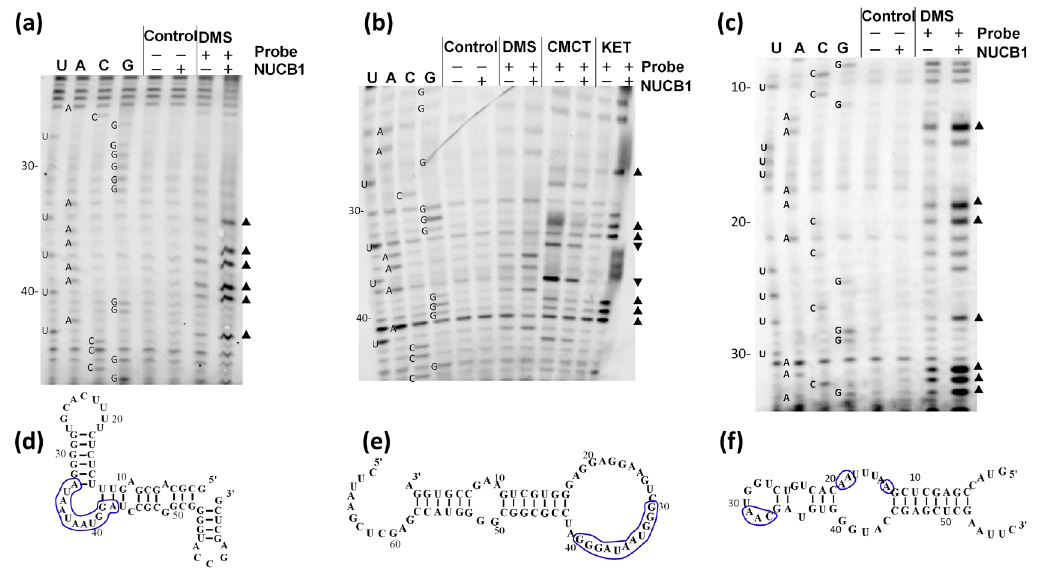
Figure 2. Chemical probing of the RNAs alone and in the presence of NUCB1 . ( a – c ) Representative gels showing structure probing of E - box RNA ( a ), SRP19 mRNA ( b ), and miR - 200a 3p RNA ( c ) using DMS, CMCT, and kethoxal (KET) in the presence and absence of NUCB1. Unmodified RNAs alone or in the complex with NUCB1 were used as controls. U, A, C, and G are sequencing lanes generated by reverse transcription in the presence of ddATP, ddTTP, ddGTP, and ddCTP, respectively. Nucleotides are numbered according to their position in an RNA transcript. The triangles on the right side of the gels indicate increased base reactivity upon NUCB1 addition, whereas the inverted triangles indicate the opposite. Secondary structure models of the used RNA fragments: E - box RNA ( d ), SRP19 mRNA ( e ), and miR - 200a 3p RNA ( f ). Nucleotides are numbered as in ( a – c ). Blue lines indicate regions whose reactivity changed in the presence of NUCB1.